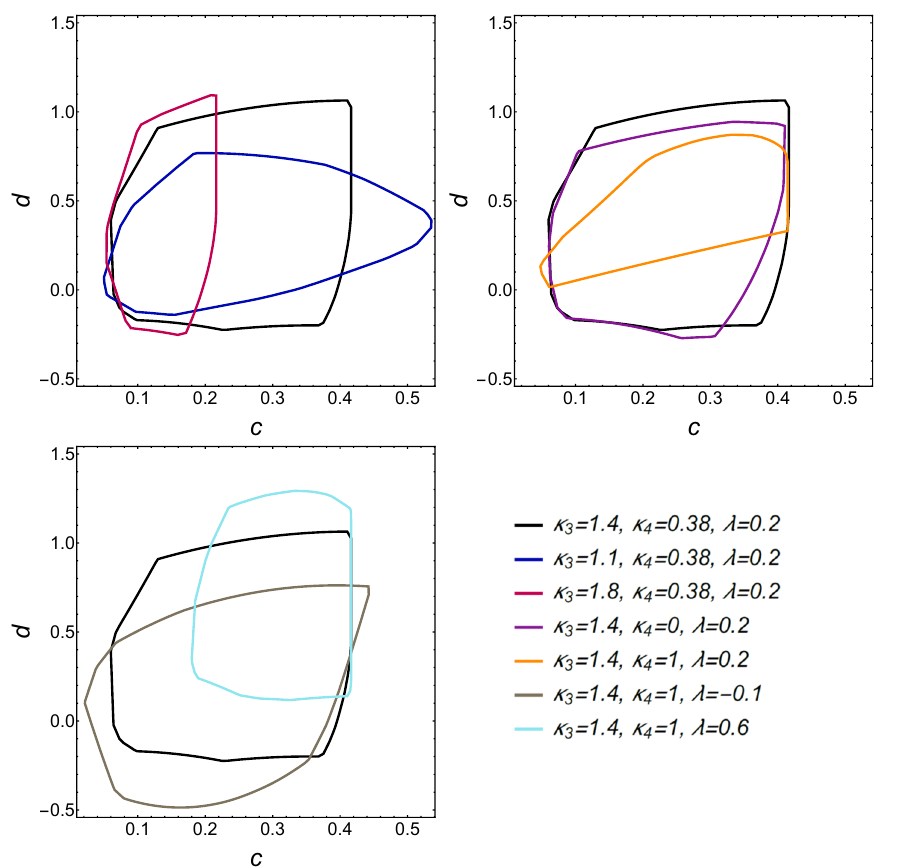
Figure 4 . Positive regions in the ( c, d ) -plane with different κ 3 , κ 4 and λ (the regions within the solid lines are allowed by generalized elastic positivity bounds) in the Z line is when parameters other than c and d take their approximate central values in eq. (4.13). The top left, top right and bottom plot show the influence of changing κ